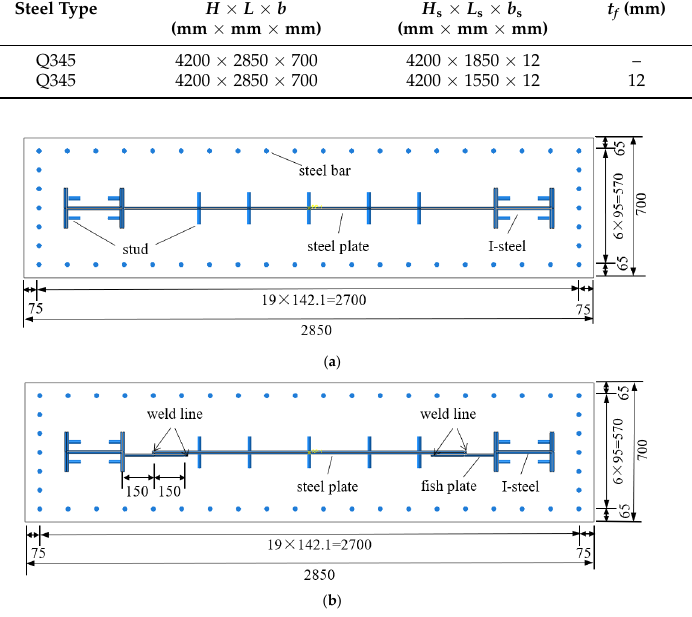
Figure 1. Cross-sections of shear wall models (mm): ( a ) GBSW; ( b ) YWBSW.